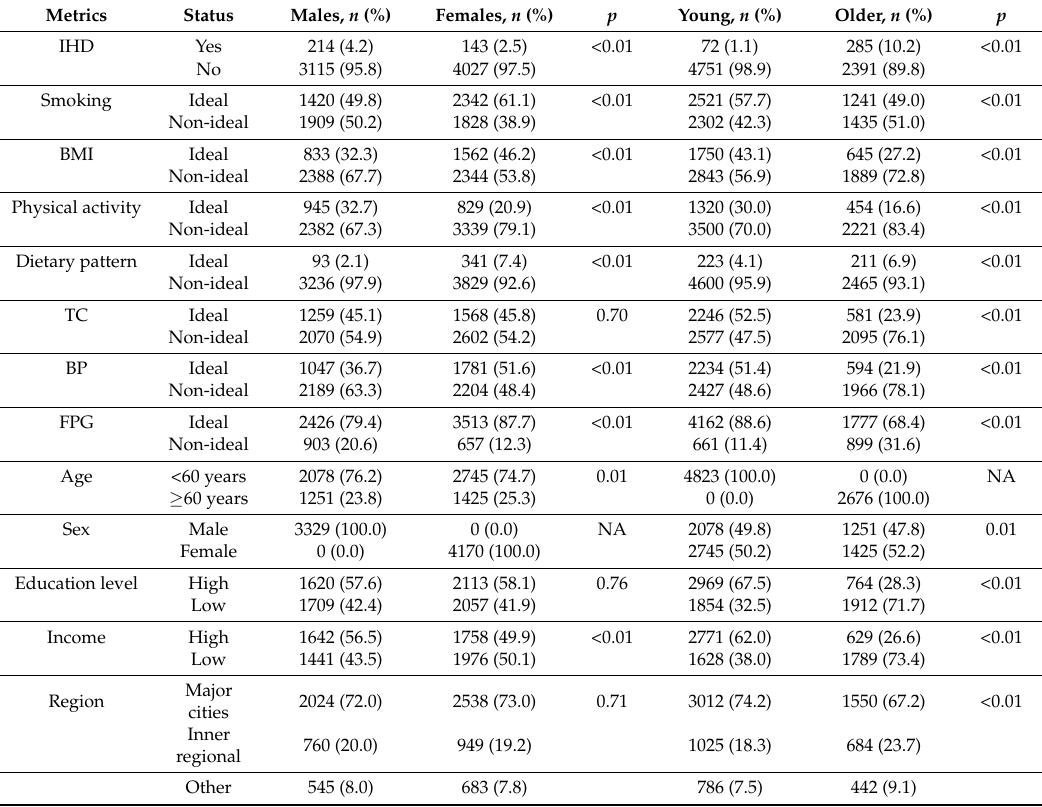
Table 1. Baseline characteristics of the included